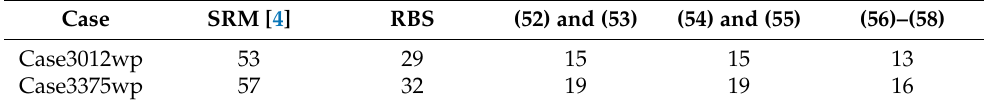
Table 6. Total iterations for ill-conditioned cases with reactive limits.